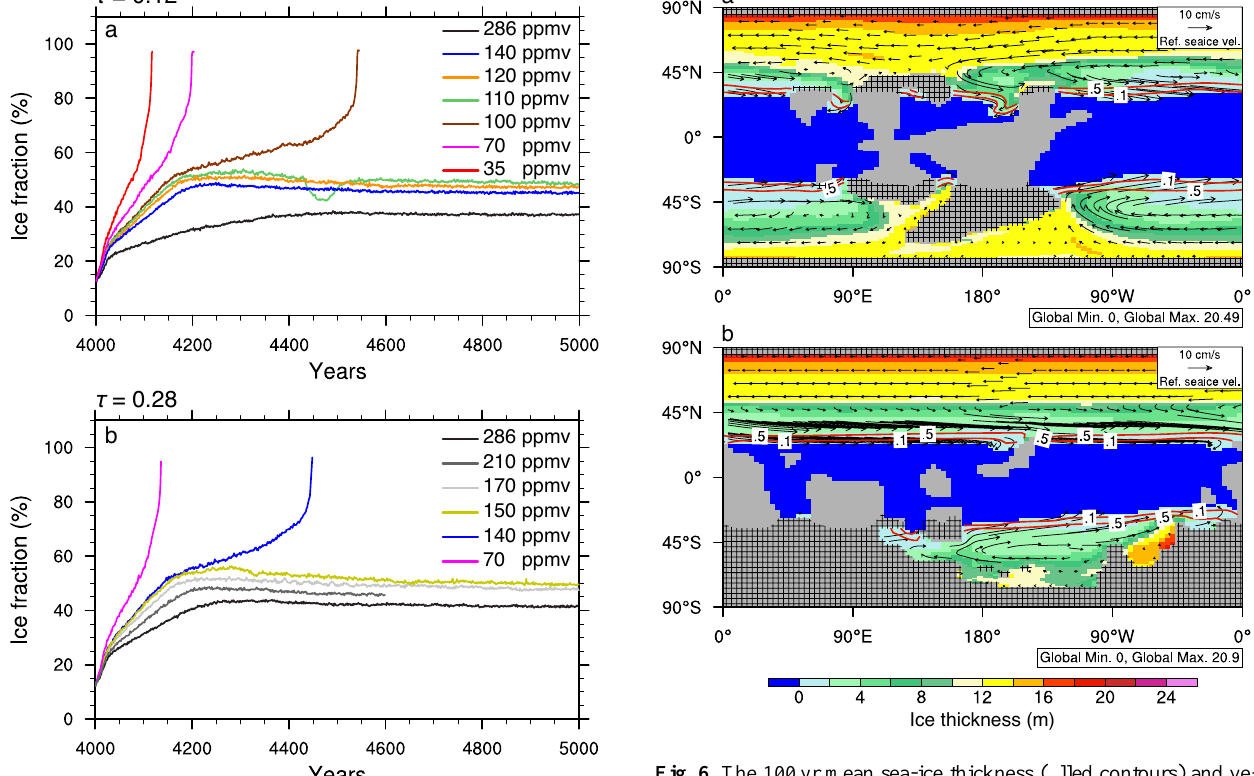
Fig. 6. The 100yr mean sea-ice thickness (filled contours) and ve- locities (the arrows) at the end of simulations. The grey area rep- resents the continent, and the hatched regions represent land snow thicker than 1cm water equivalent. All sea ice with grid-box frac- tion greater than 1% is plotted, but the contour lines (red curves) for grid-box fraction of 10% and 50% are also superimposed. In these two simulations, TSI = 0.94TSI 0 , p CO 2 = 140 ppmv, τ = 0 .